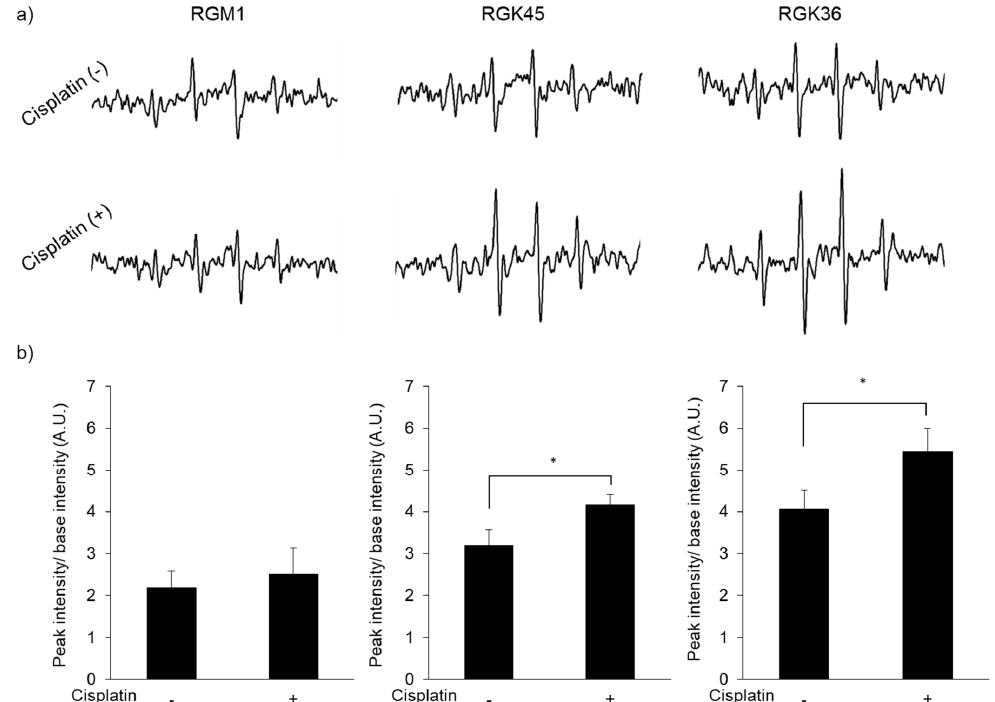
Figure 2. Intracellular reactive oxygen species (ROS) production after treatment with or without cisplatin (10 µ M). ( a ) The electron spin resonance (ESR) spectra. ( b ) Relative ESR intensity. Intracellular ROS concentration in RGK36 and RGK45 were increased after cisplatin treatment, while RGM1 cells were not. Data are expressed as means ± SD (n = 3). * p < 0.05, ** p <